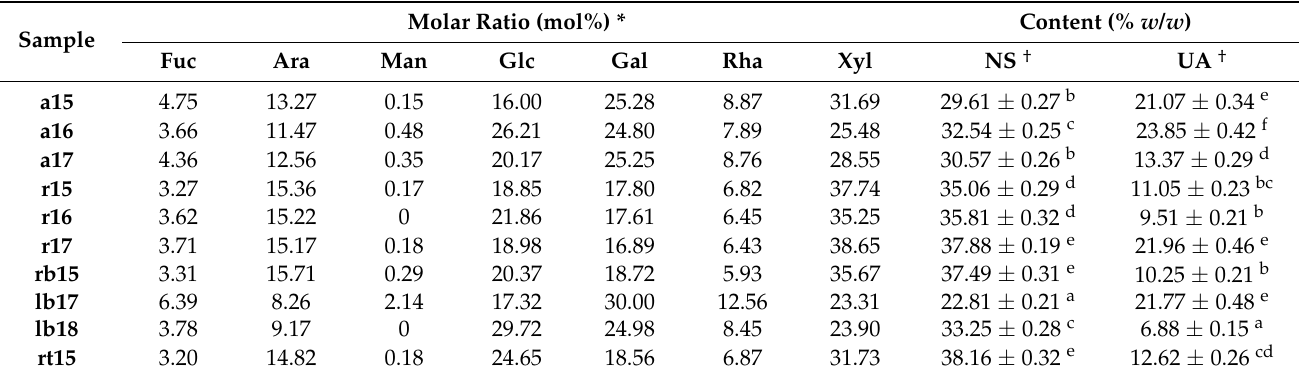
Table 4. Monosaccharide composition of FSM extracted from various cultivars (NS, UA: mean ± SD, N =